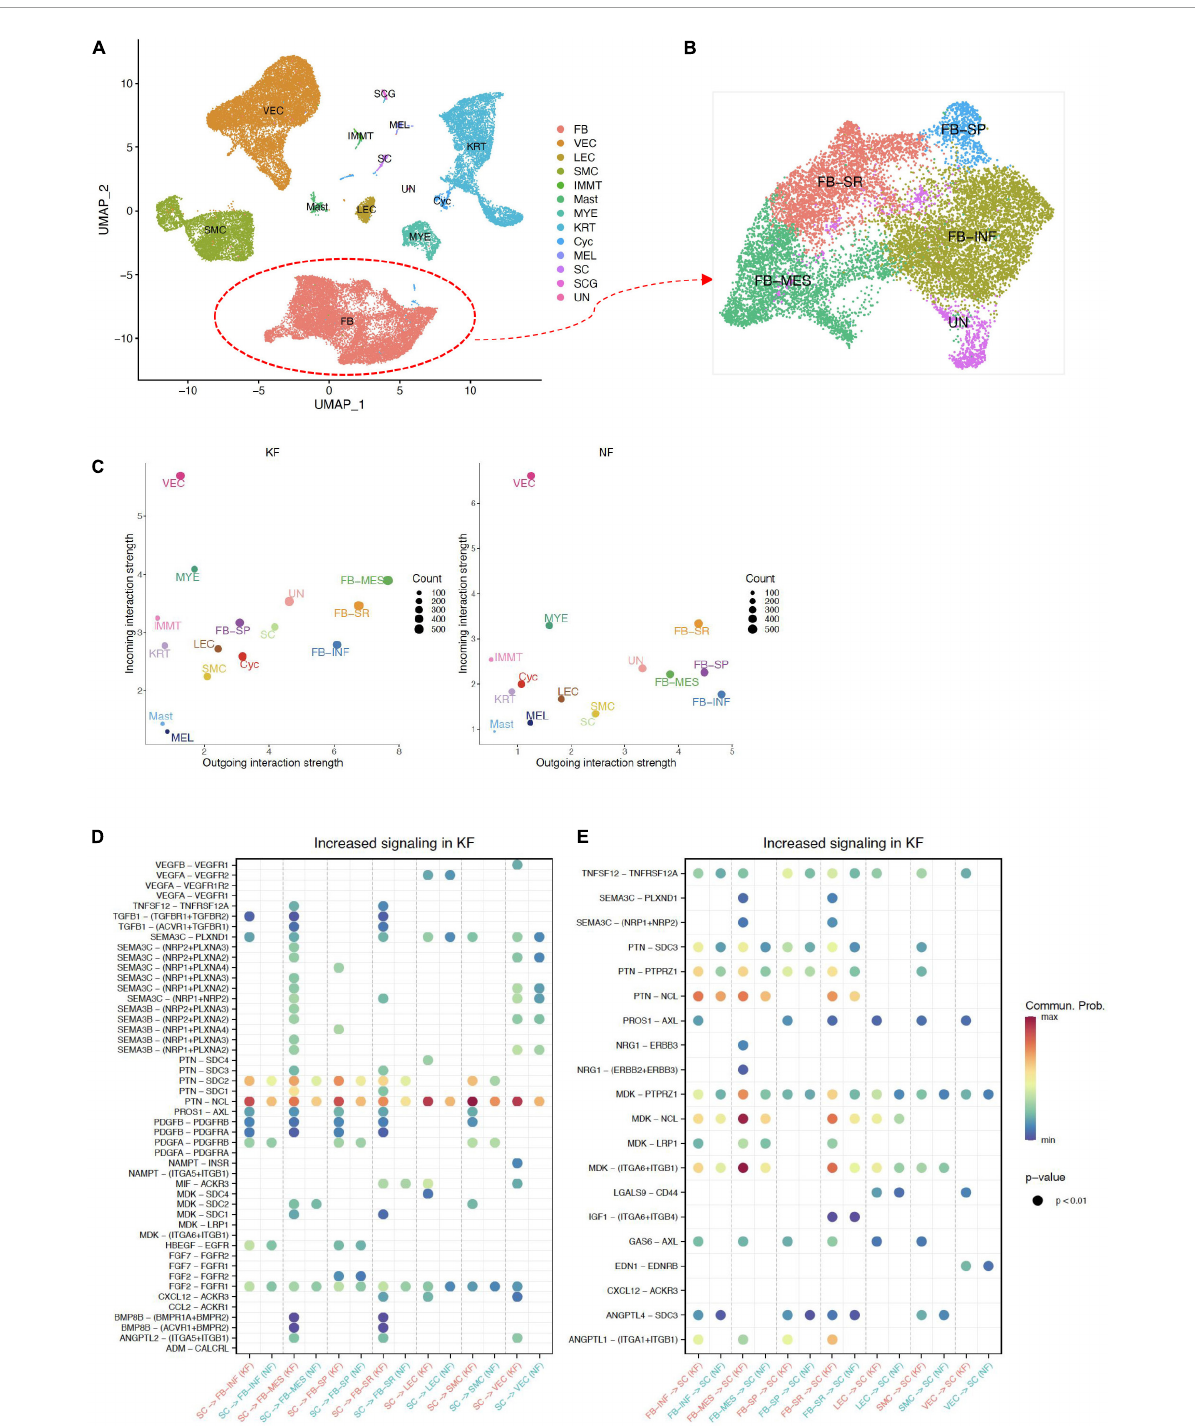
FIGURE5 Interactions between ECM-related populations and SC in chest/back keloids. (A) UMAP plots of all cells in chest/back keloids, the clustering resolution was 1.5. (B) UMAP plots of fibroblasts in chest/back keloids, the clustering resolution was 1.0. (C) Comparing the outgoing and incoming interaction strength in 2D space by scatter plots to allow identify the cell populations with significant changes in sending or receiving signals in chest/back keloids (KF) and normal skin (NK), respectively. (D) The significant ligand–receptor pairs between ECM-related subpopulations and SC in chest/back keloids (KF) vs. normal skin (NK). Here, SC were as sources. P -value < 0.05 was considered significant interactions. (E) The significant ligand–receptor pairs between ECM-related subpopulations and SC in chest/back keloids (KF) vs. normal skin (NK). Here, SC were as targets. P -value < 0.05 was considered significant